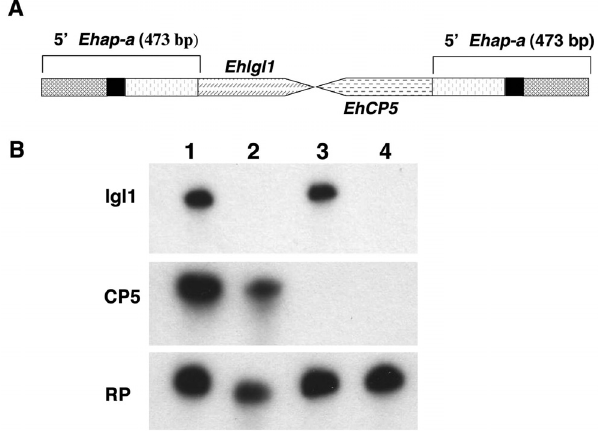
Fig. 2. – (A) Schematic diagram of plasmid pRB9 enabling the simul- taneous silencing of two additional genes, Ehlgl1 and Ehcp-5 , in G3 Ehap-a -silenced trophozoites. (B) Northern blot analysis of amoebic RNA extracts. Lanes: 1, plasmid-less G3 clone; 2, RBV clone silenced in Ehlgl1 ; 3, RB8 clone silenced in EhCP-5 ; 4, triple-gene-silenced RB9 clone silenced in both Ehlgl1 and EhCP-5 . The probes used are as indicated. Trophozoites that are multiple gene silenced (Bracha et al ., 2006) are virulence-attenuated and could be prime candidates for the development of a live